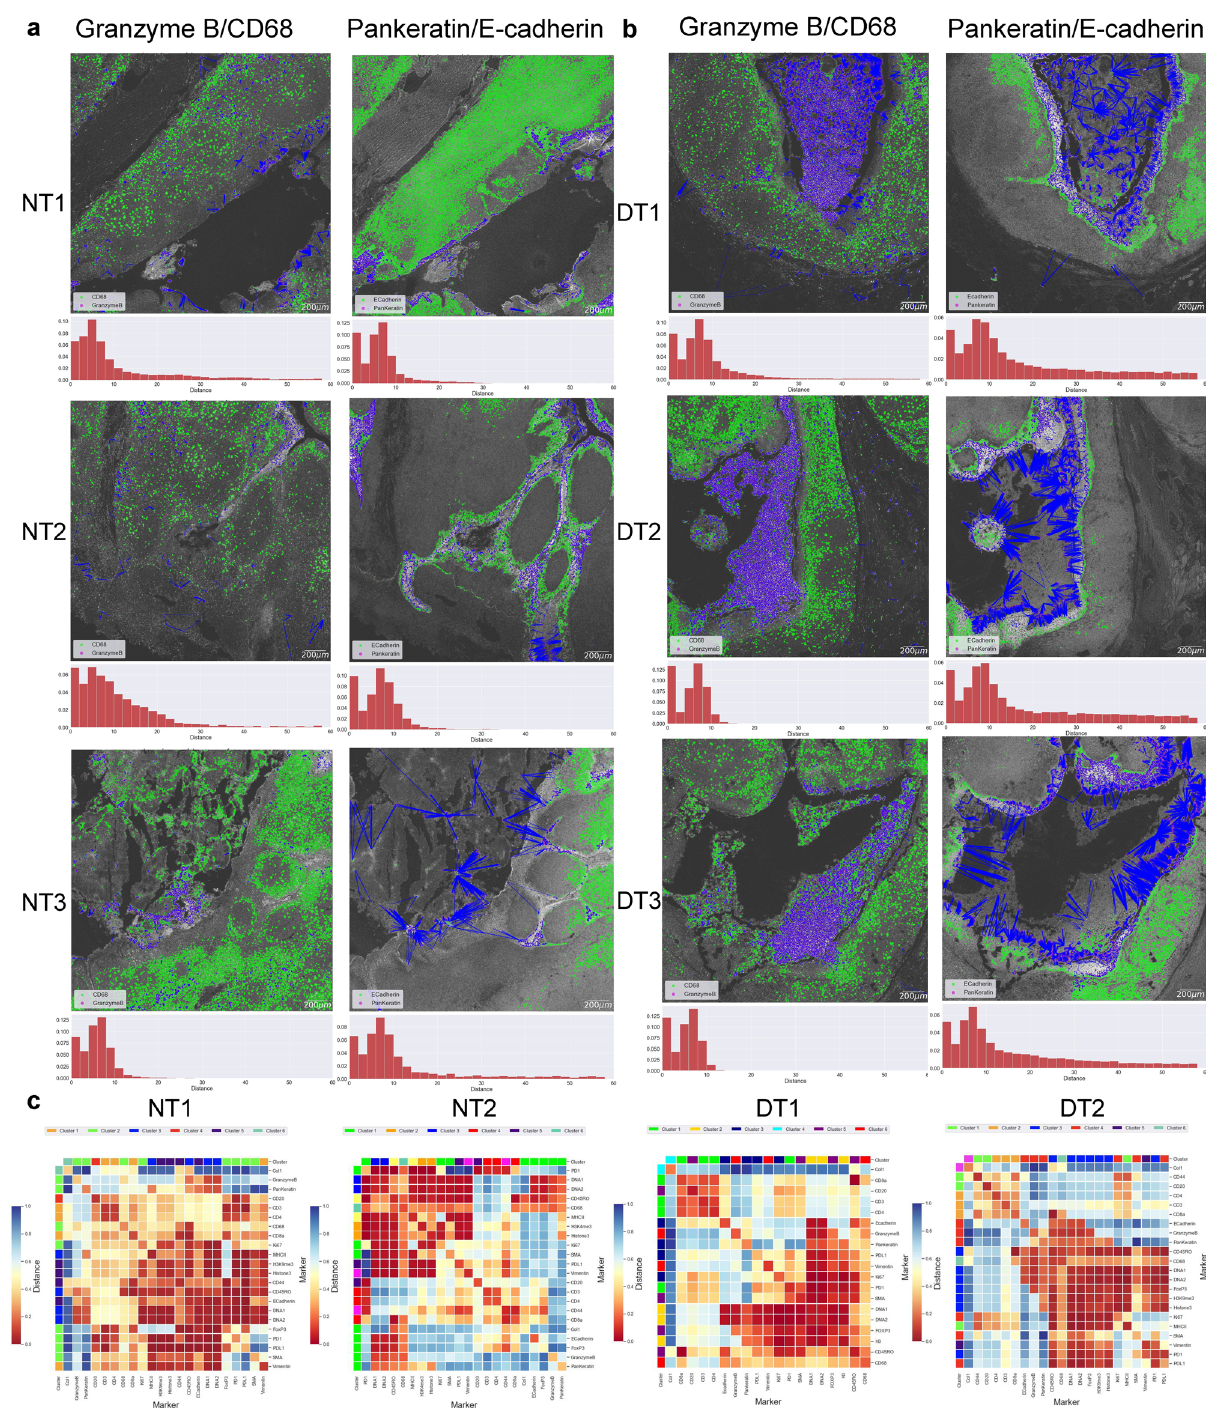
Fig. 6 Spatial proximity maps of cell-pairs within a k-nearest neighbor (k-NN) distance in healthy and disease tonsil tonsils. a , b Spatial proximity maps of cell-pairs within k-NN of 5-cell radius distance in healthy and diseased tonsils are visualized. Magenta and green color represent individual cells in the pair of markers (Granzyme B/CD68 and Pankeratin/E-cadherin), wherein the blue is the distance vector between the marker pairs for each cell. The scale bar is 200 µ m. The histogram shows the distance distribution for each pair of markers, with the y -axis showing the proportion corresponding to the distance on the x -axis. The x -axis is distributed in 20 bins of data. c Heatmap representations of the average spatial proximity distances between the pairs of all the markers in the multiplexed IMC data are